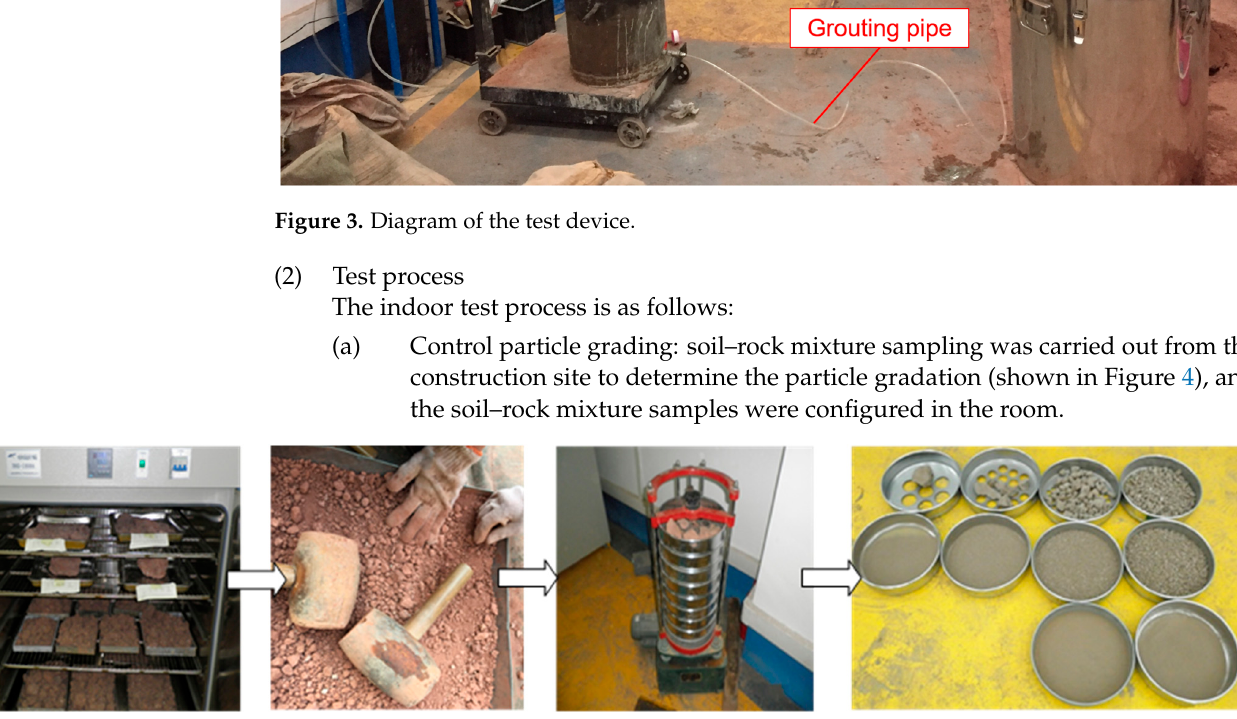
soil; ( c ) sieving the samples; ( d ) separating each particle size and weighing.